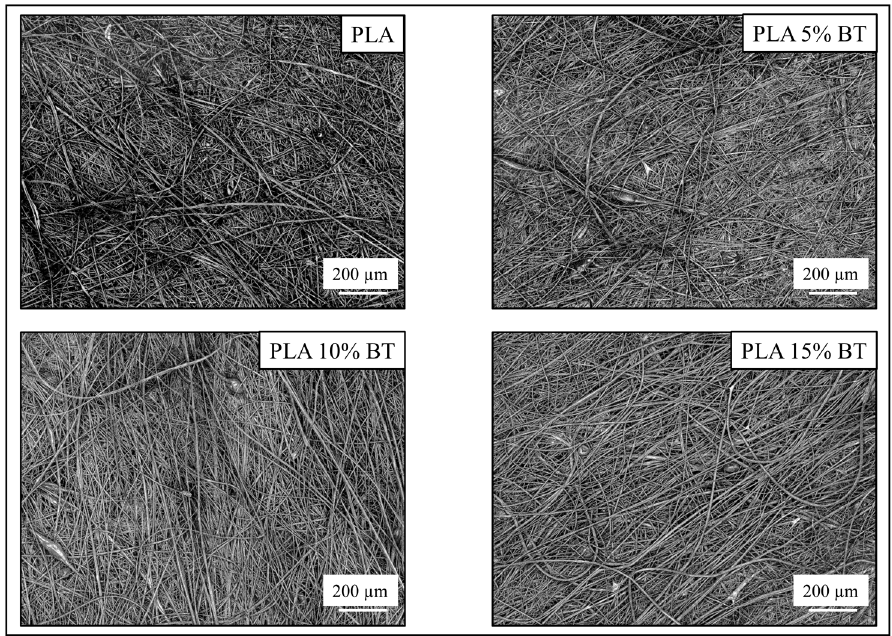
Figure 1. 3D laser micrographs of the four different substrates obtained before the aging treatment at 150 × of magnification.